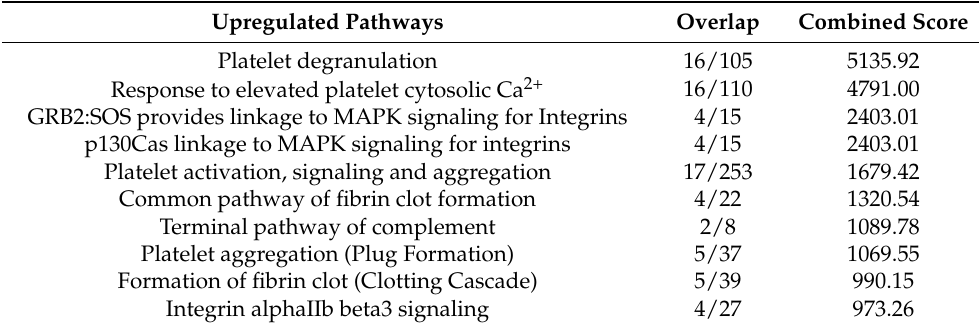
Table 1. Top 10 upregulated pathways for the infarct core compared to unaffected tissue (green vs. red), with an adjusted p -value < 0.05 and ranked by the combined score 1 .